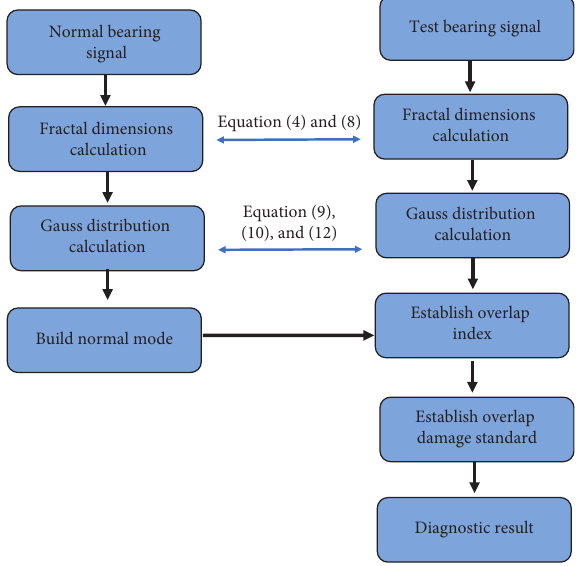
Figure 5: The flow of the bearing failure